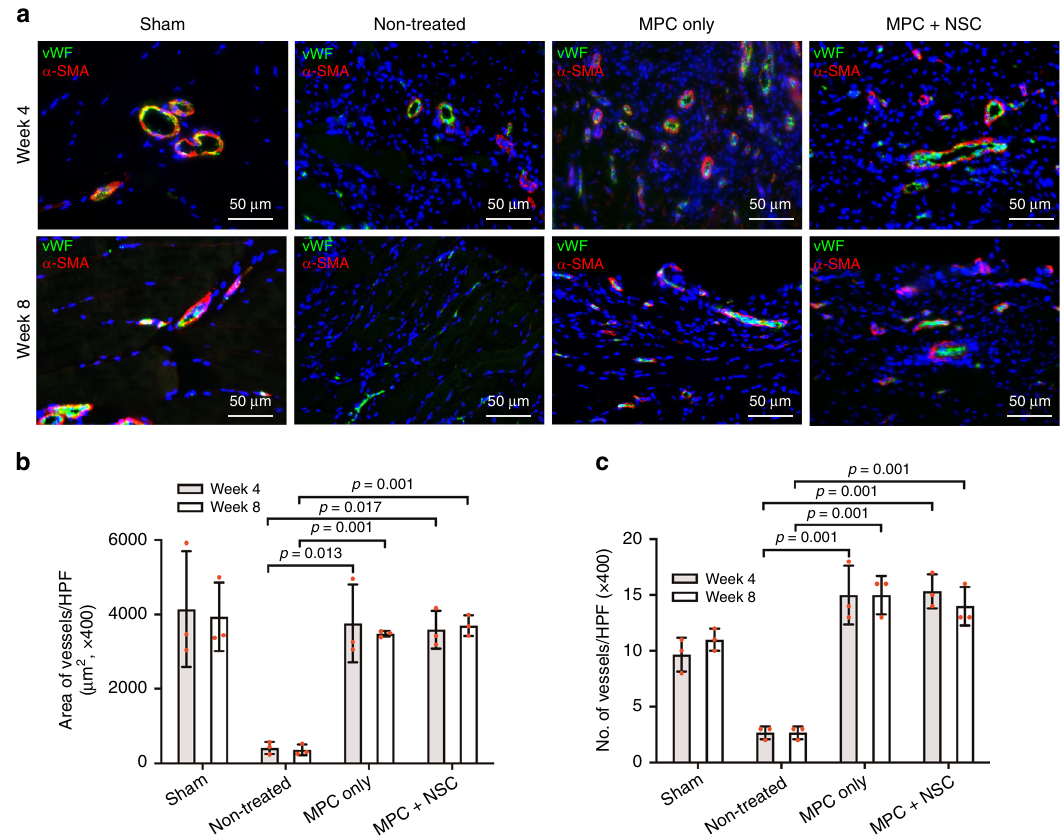
Fig. 8 Vascularization of 3D bioprinted skeletal muscle constructs. a Immuno fl uorescence for von Willebrand factor (vWF, green)/alpha smooth muscle actin ( α -SMA, red) of injured TA muscles at 4 and 8 weeks after implantation. b , c Quanti fi cation of b area of vessels per HPF ( µ m 2 ) (×400, n = 3 per group and time point, three random fi elds per sample) and c number of vessels per HFP (×400, n = 3 per group and time point, three random fi elds per sample). Bioprinted constructs implanted at the site of the muscle defect injury were vascularized, as con fi rmed by vWF + / α -SMA + vessels, but there was no signi fi cant difference between the MPC only and MPC + NSC groups. All data are represented as mean ± SD. The p -values by two-way ANOVA followed by Tukey ’ s test are